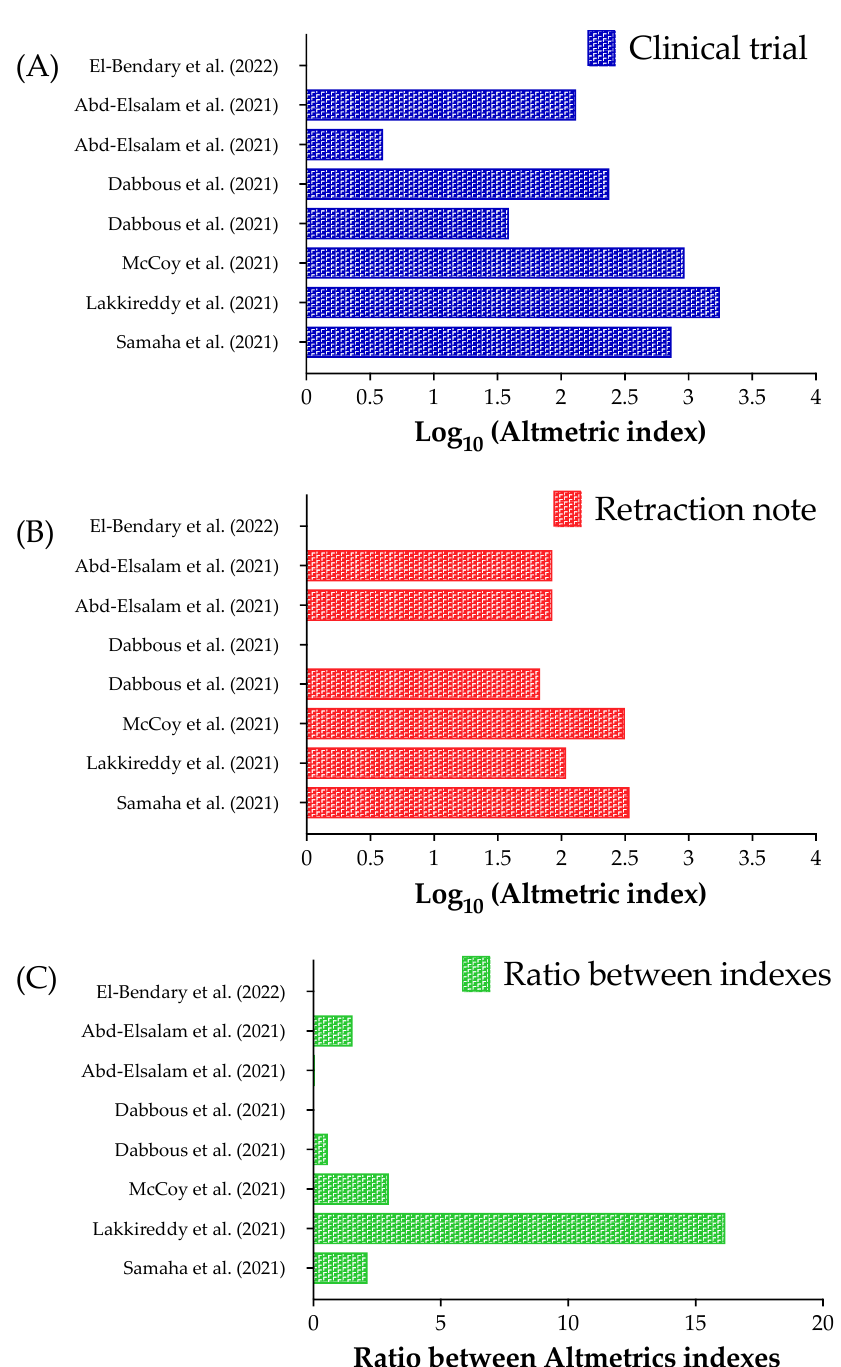
Figure 2. Altmetric index for the clinical trials and their retraction notes related to Coronavirus Disease (COVID-19) interventions. ( A ) Altmetric index for the clinical trials. ( B ) Altmetric index for the retraction notes. ( C ) The ratio between the Altmetric index for the clinical trials and their retraction notes. We presented the Altmetric index using a Log 10 scale in ( A , B ). It was impossible to calculate the ratio between the Altmetrics indexes for two clinical trials and their retractions notes [13,16]. The Altmetric index was obtained using the “Altmetric it!” when logged in Pubmed for each clinical trial and its retraction note. References: [9-16]. Of those retracted papers, one evaluated Ivermectin (PubChem CID: #6321424; C 48 H 74 O 14 ) as a potential agent to control the viral load of SARS-CoV-2 among